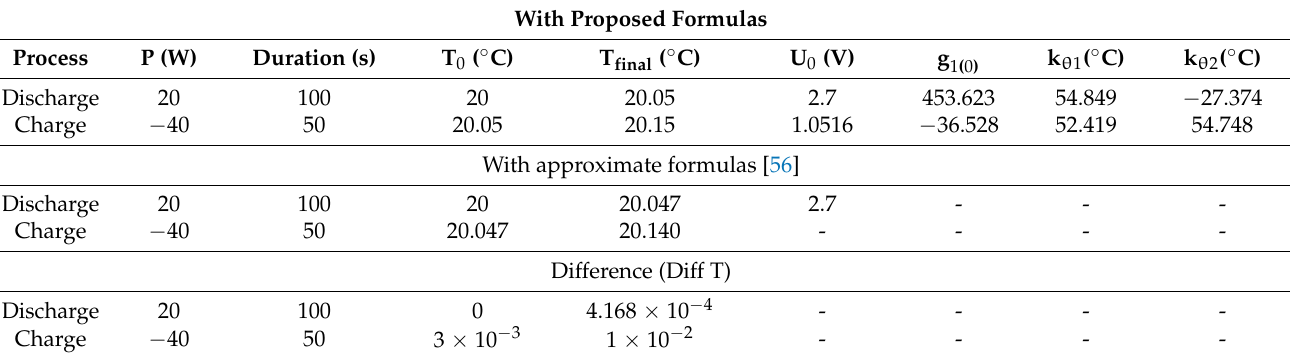
Table 2. Charge and discharge parameters at a low